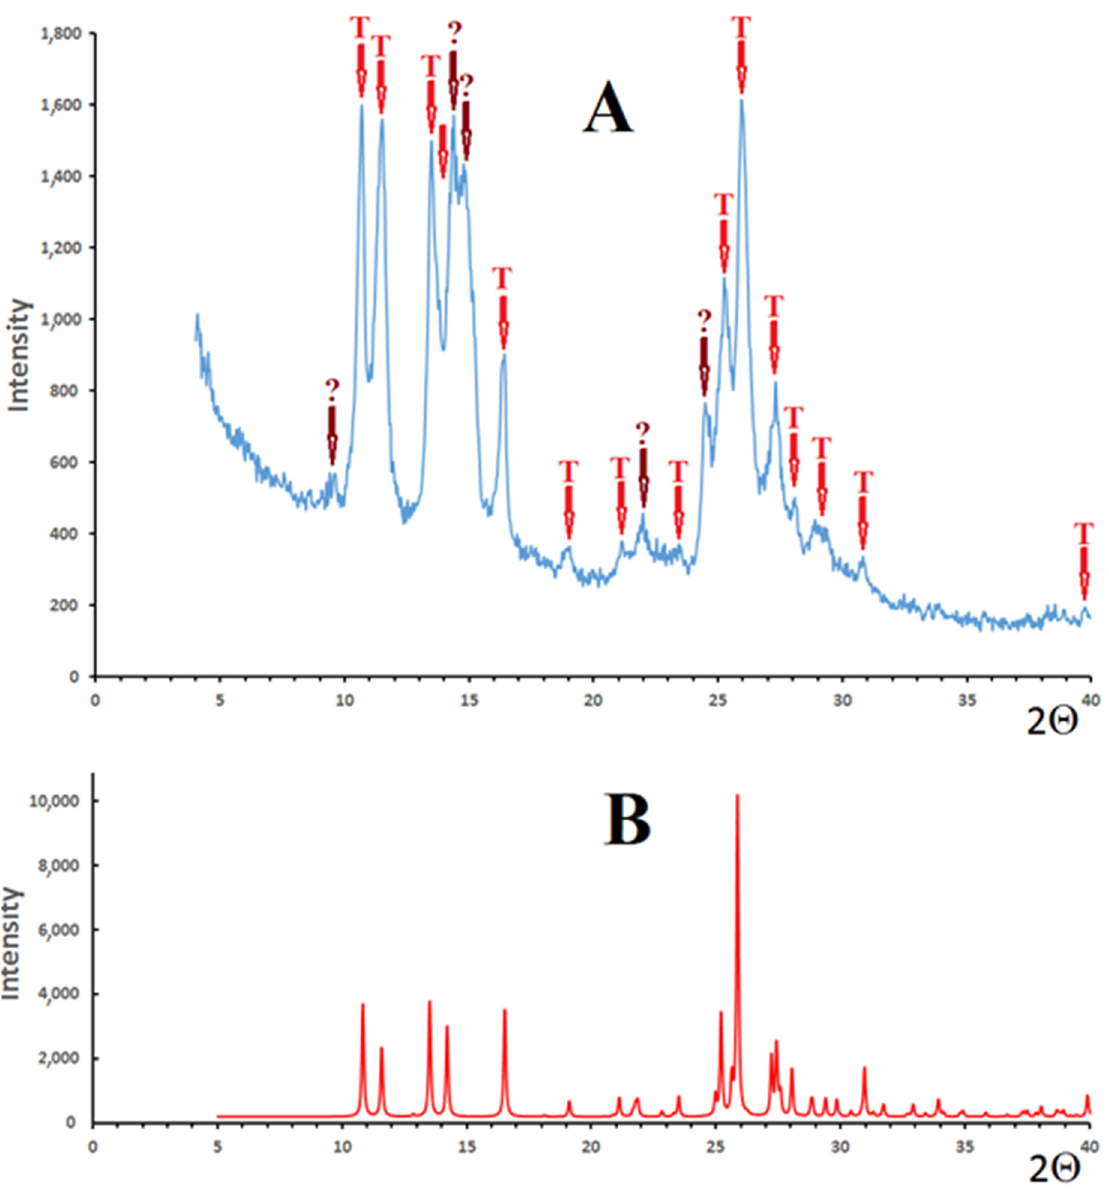
Figure 5. ( A ) experimentally recorded diffractogram of dioxidine obtained with a carrier gas flow (CO 2 ) 7.0 × 10 17 (?—unknown phase N of dioxidine), ( B ) theoretical diffractogram of the triclinic phase of dioxidine (T-phase) [41].